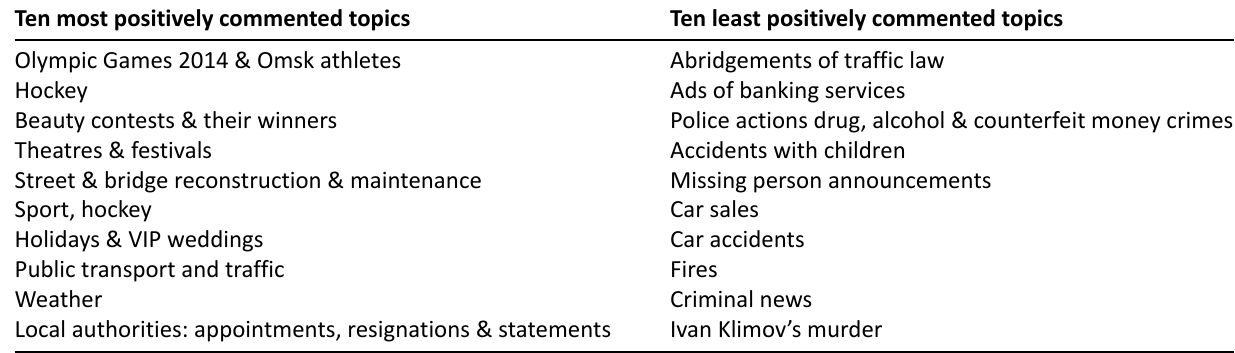
Table 3. Prevailing sentiment of the comments (max = 100%; min =